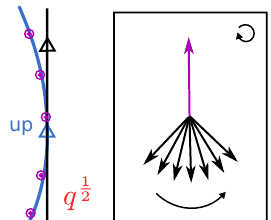
Figure 48 . An example of the framing factor contribution to (cid:11) ( e L ) for e L in standard framing. The framing vector is shown in purple while the foliation vector is shown in